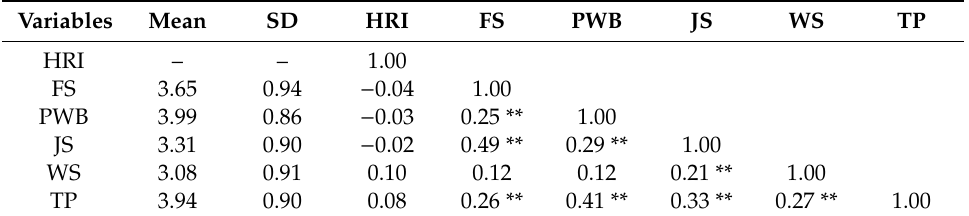
Table 6. Descriptive statistics and correlation matrix for young